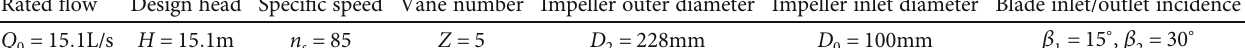
Table 1: The basic design parameters of the impeller.